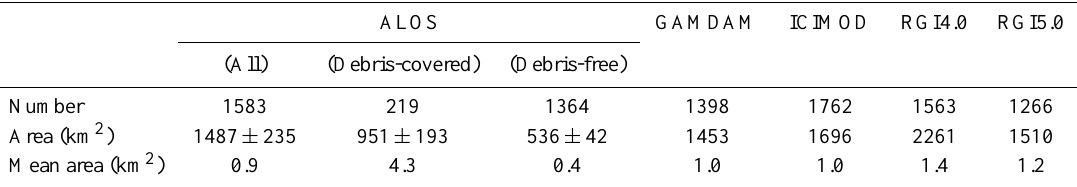
Table 2. Glacier number and area data from the ALOS (all, debris-covered/debris-free), GAMDAM, ICIMOD, RGI4.0, and RGI5.0 inven- tories for the Bhutan